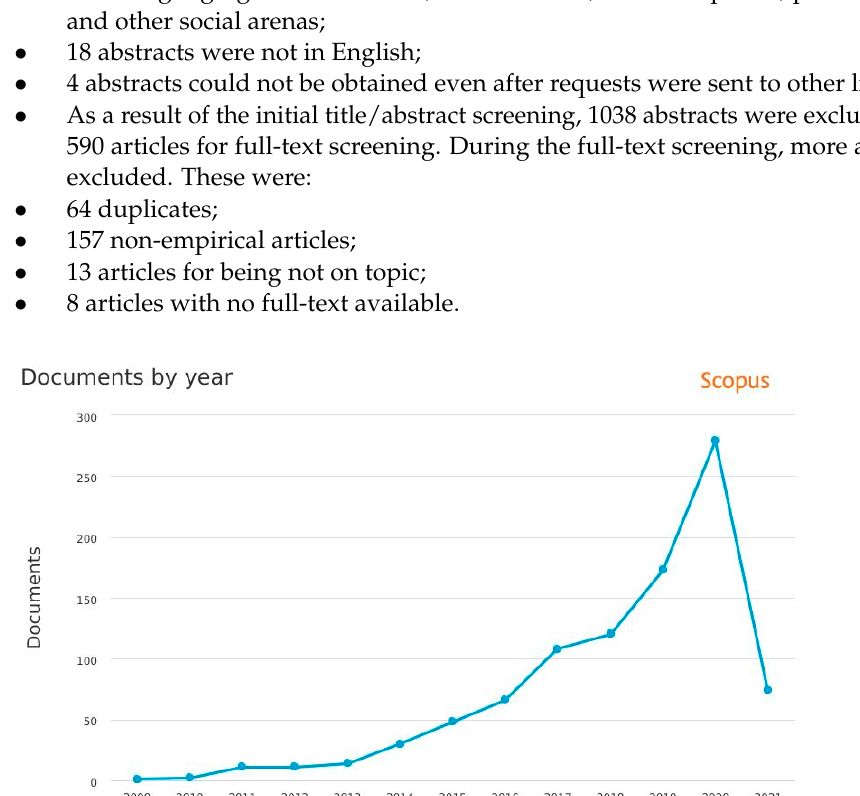
Figure 2. Publications on translanguaging by year (https://www.scopus.com/home.uri, accessed on 12 February 2021).